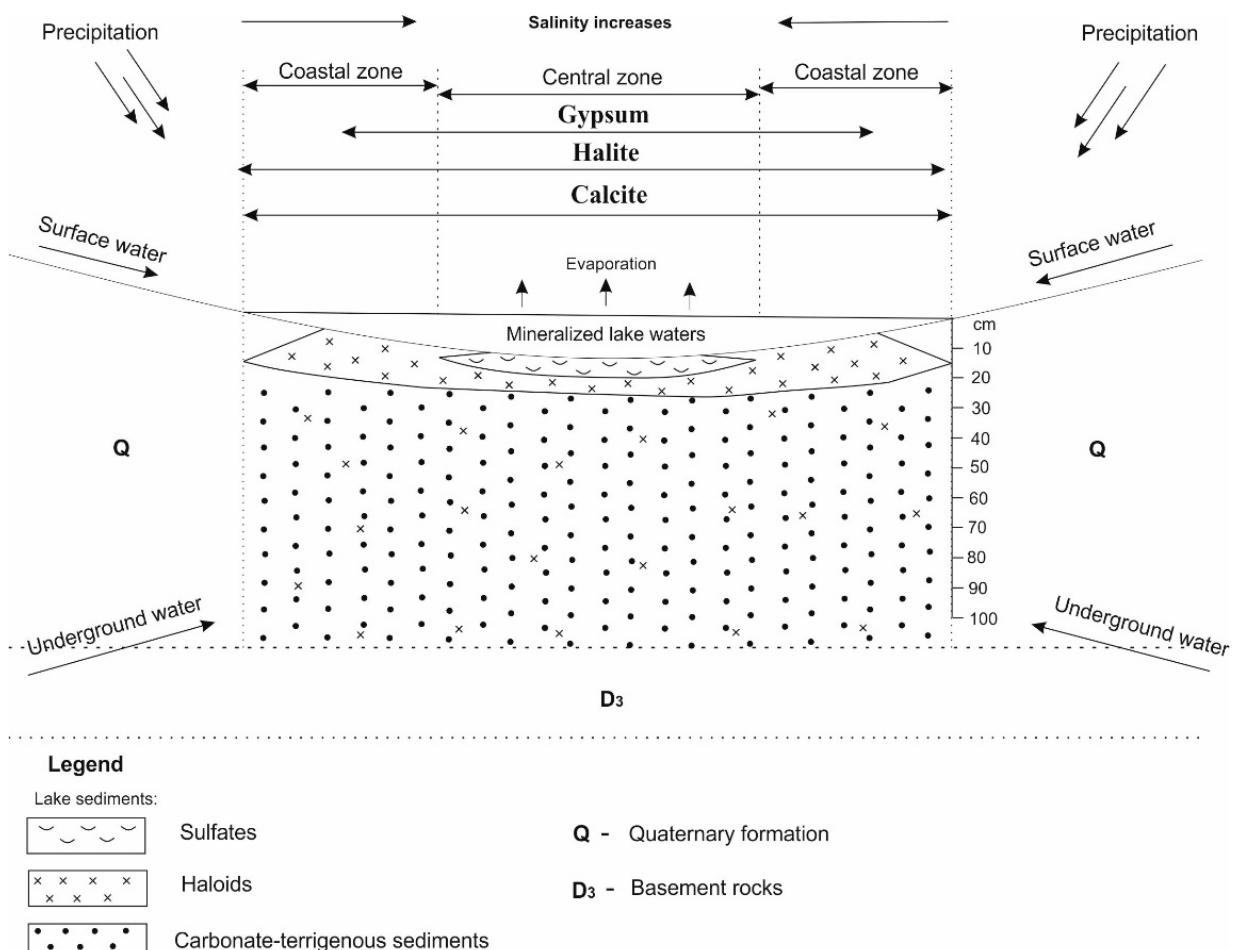
Figure 9. Model-based diagram of the mineralogical distribution of Lake Taloe sediments [14].